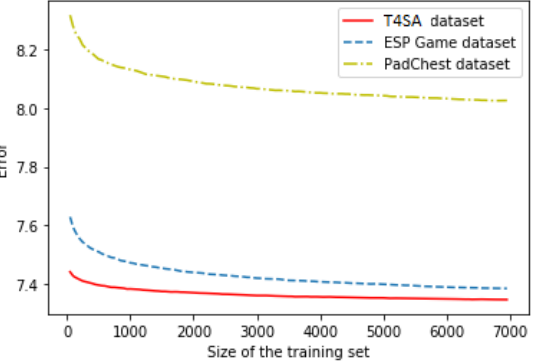
Figure 6. Comparison of the learning performance for the three data sets using the ResNet50 image features.